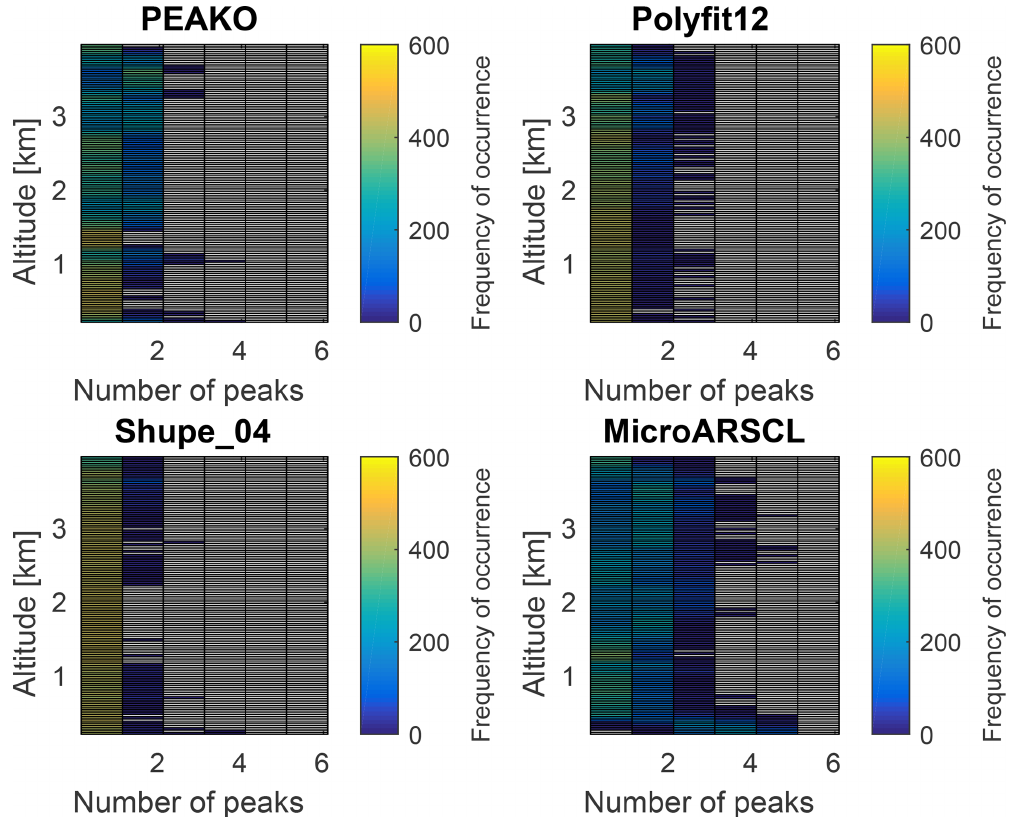
Figure C3. Like Fig. 6 but for the case study period on 7 February 2014, 23.75–24UTC, at 0.2–4km altitude.